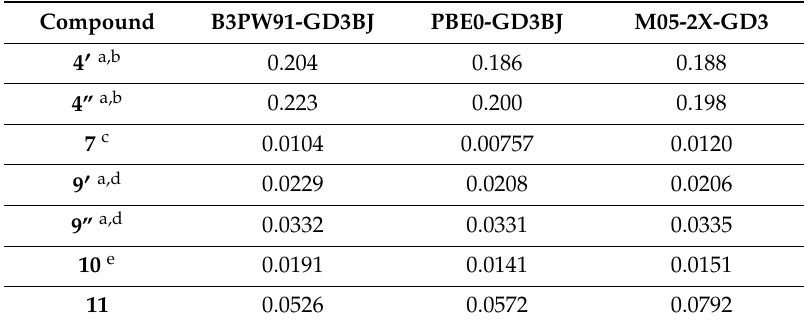
Table 3. Minimized mean sum of squared distances (MSSDs) between equivalent heavy (non-H) atoms in calculated and experimental molecular